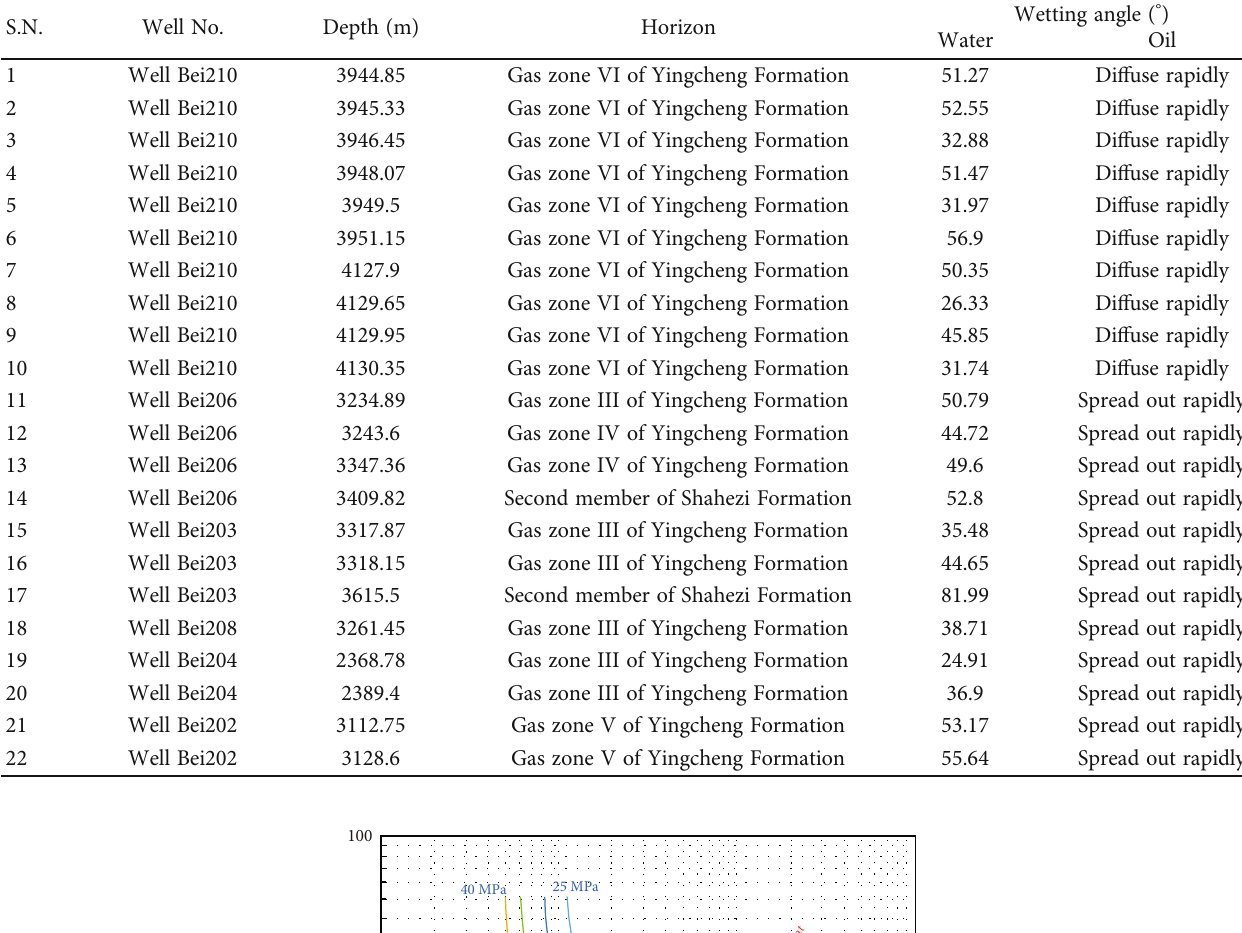
Table 1: Wettability measurement results of rocks in the Longfengshan sub-sag.